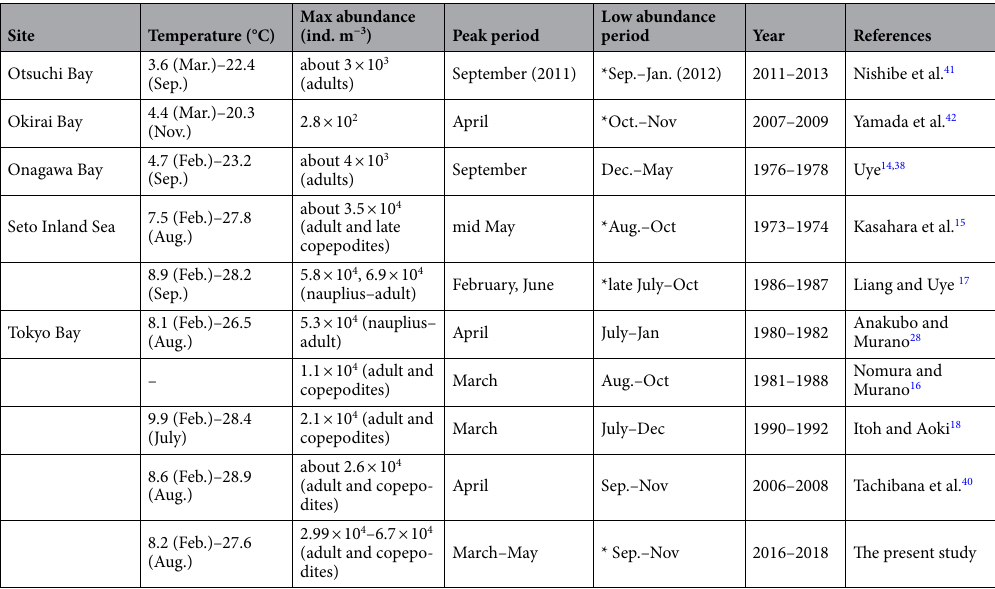
Table 1. Abundance of Acartia omorii and water temperature range in each site in Japan. *Population completely disappeared in water column, the others are considerable low